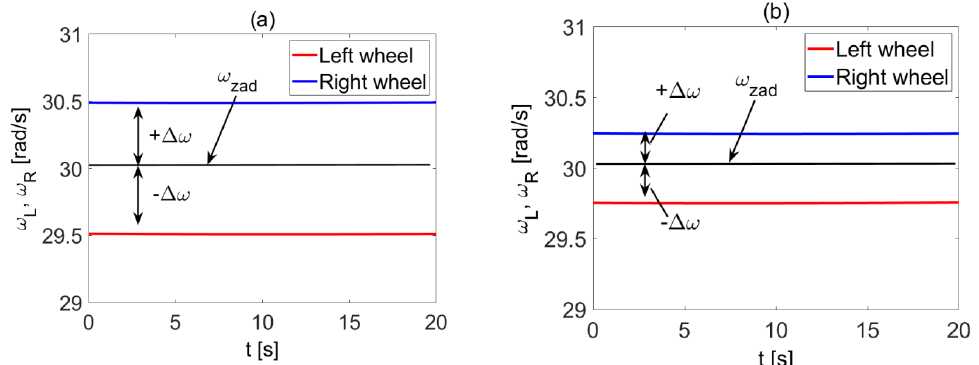
Figure 19. Waveforms of Rotational speeds of individual wheels while the trolley moves along the curve of the track with a radius of 50 m ( a ) and 100 m ( b ).